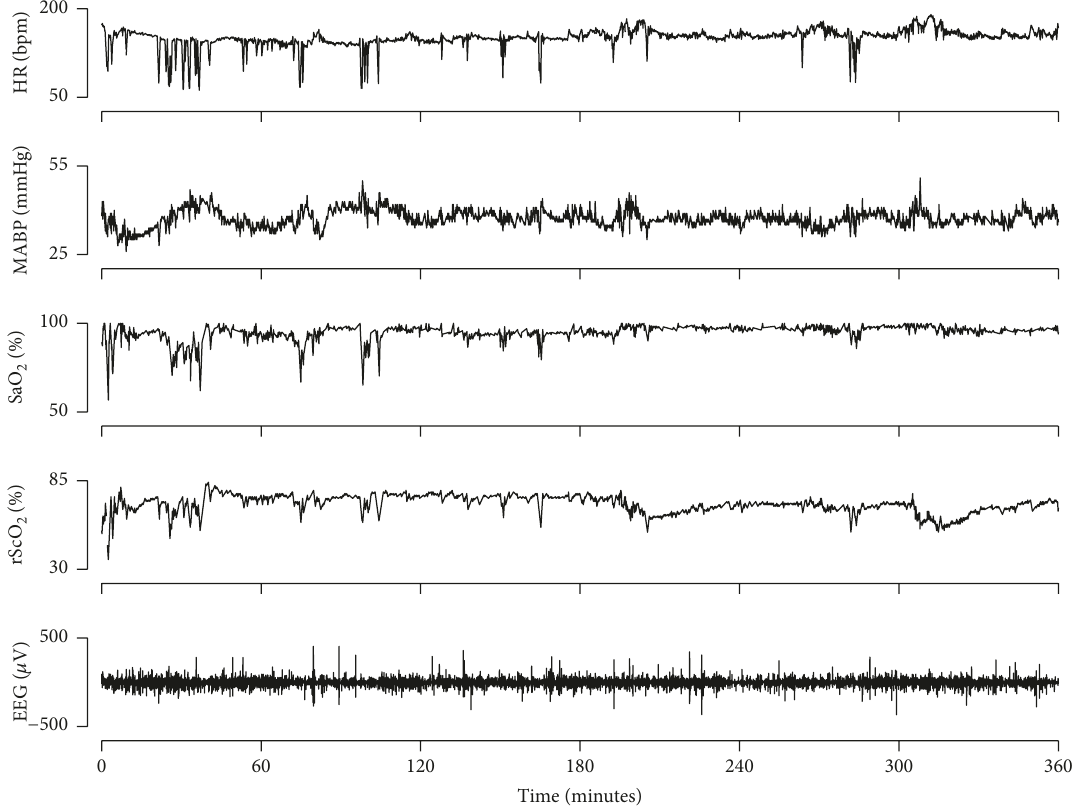
Figure 1: Illustration of the 5 signal modalities used to construct graph models for the neonates. A 6-hour long segment of multimodal data is presented for one neonate in the group of study (PMA 27 weeks, 0.5mg · kg − 1